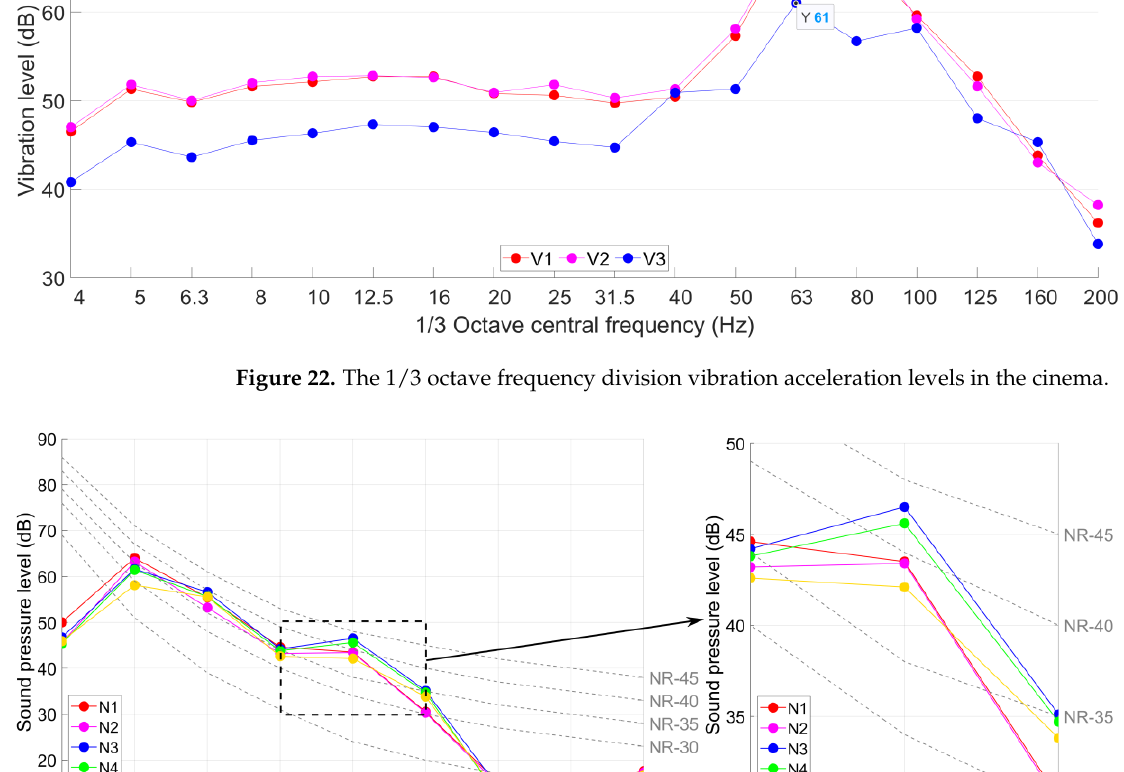
17 of 21 Figure 21. Setup of sound pressure test points in Hall A (left) and Hall B (right) in the cinema. The vibration acceleration levels obtained from the test points in the cinema are pre- sented in Figure 22. It can be seen that the responses of the two vibration test points in Hall A are consistent with each other. The VL max is 70 dB and the corresponded frequency band is 63 Hz. Since both test points V1 and V2 are set up on the same beam, the measured